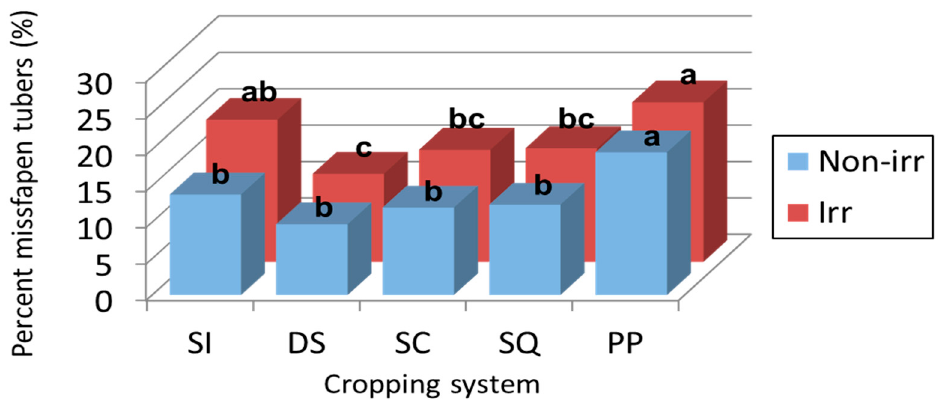
Figure 3. Effect of cropping system (SQ—standard rotation, SC—soil conserving, SI—soil improving, DS—disease suppressive, and PP—non-rotation control) and irrigation (Non—Non-irrigated and Irr—Irrigated) on average percentage of severely misshapen tubers as averaged over a 5 year period (2006–2010). Bars topped by the same letter within each irrigation regime are not significantly different from each other based on ANOVA and Fisher’s protected LSD test ( p < 0.05).